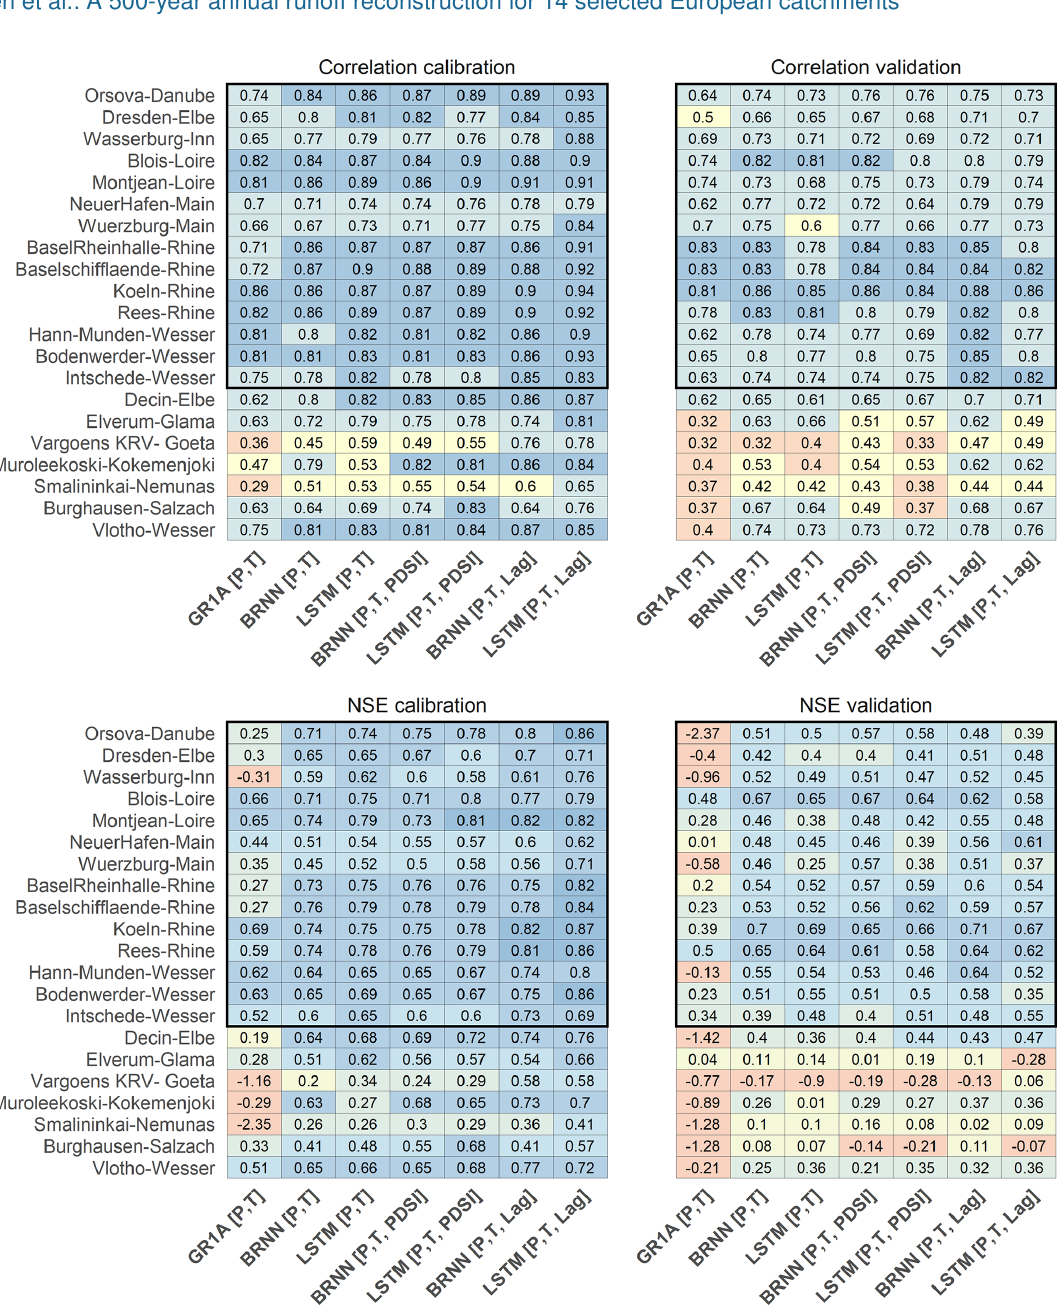
Figure 5. The correlation coefficient (top) and NSE (bottom) for calibration (left) and validation (right) of the considered models for 21 study catchments. The vertical axis represents the catchments (station name and river) and the horizontal axis the considered models. The rectangular black frames represent the catchments with NSE > 0.5 over the validation